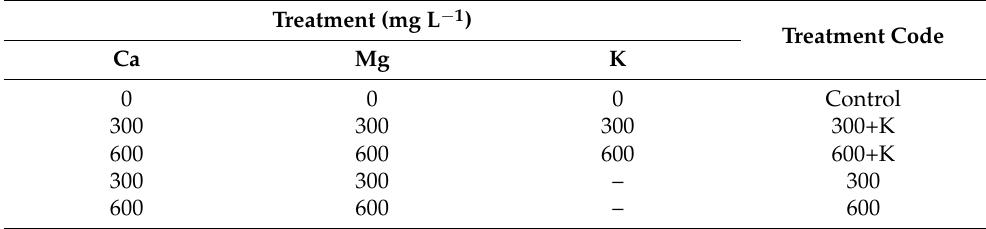
Table 3. Spray treatments of Ca, Mg, and K evaluated in the TDG hazelnut orchards of Cunco (38 ◦ 58 (cid:48) 19.8” S, 72 ◦ 07 (cid:48) 33.0” W), Gorbea (39 ◦ 04 (cid:48) 23.6” S, 72 ◦ 41 (cid:48) 48.7” W), Perquenco (38 ◦ 25 (cid:48) 33.2” S, 72 ◦ 21 (cid:48) 16.9” W), and Radal (39 ◦ 01 (cid:48) 06” S, 72 ◦ 19 (cid:48) 11” W) in the La Araucan í a region during the 2018/19 season.